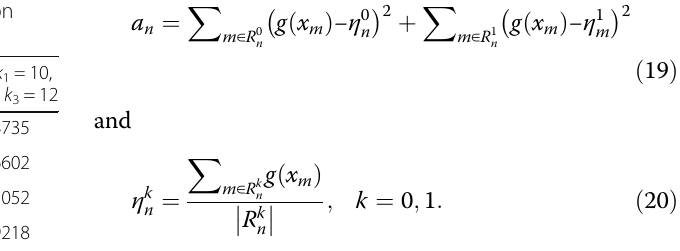
denotes the matching error between the In (18), a n n th mold and the image block. Thus, the minimum of a represents the best matching mold to the image block n among all the candidate molds. N , which is 56, is the R number of total molds, R 0 and R 1 respectively represent n n the black and white regions in the n th mold as shown in is the average of texture values Fig. 2. With k = 0 or 1, η k j in R k , and R k n n (19), we use the least squares error method to predict for the image block. To find the best the best mold, M I g